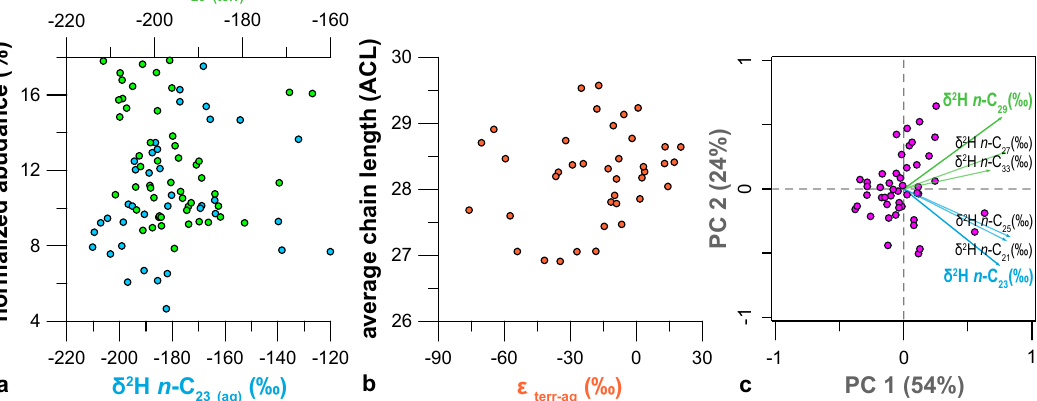
Fig. 5 Relations between n -alkane chain length and isotope values. Bi-plots showing a The hydrogen isotope ( δ 2 H) composition of representative mid- (C 23 ) and long-chain (C 29 ) sedimentary n -alkane sample combinations versus their normalized abundance, b The isotopic offset between compounds produced by representative aquatic (C 23 ) and terrestrial (C 29 ) plants ( ε terr-aq ) versus the Average Chain Length (ACL) of all alkanes measured in these samples ( n = 39), and c Sample (pink dots) and variable (vectors) scores for the main ordination axes (PC 1 – 2: labeled with their explanatory power) of principal component analysis (PCA) carried out on measured δ 2 H values of analyzed n -alkanes ( n -C 21 to n -C 33 without n -C31: see methods section).